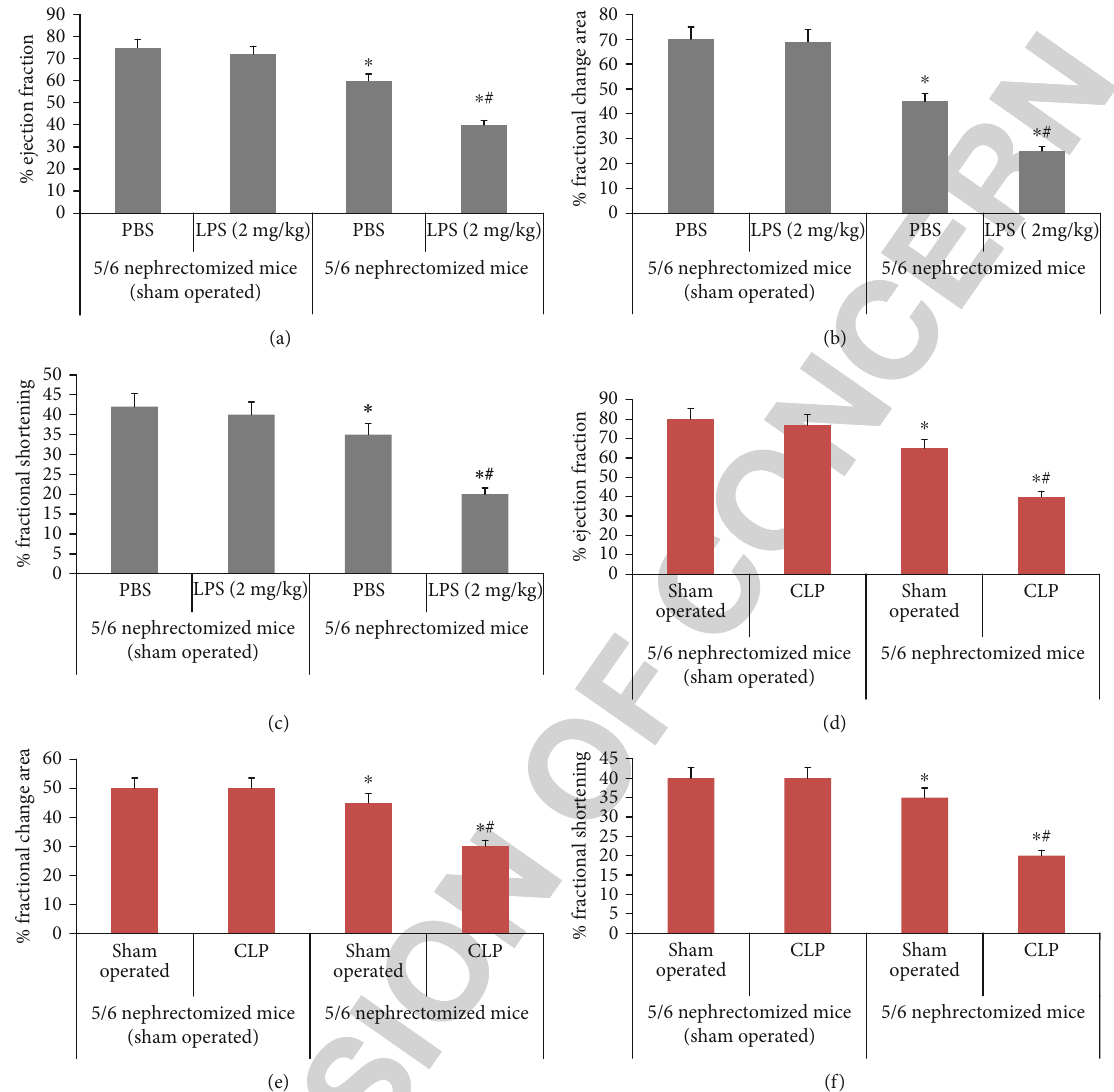
Figure 1: 5/6 nephrectomy-induced chronic kidney dysfunction causes augmentation of cardiac dysfunction mediated by LPS administration or CLP. (a – c) 5/6 nephrectomized sham or 5/6 nephrectomized mice were treated with either LPS (2 mg/kg) or vehicle, i.e., PBS intraperitoneally. The cardiac function was evaluated after 18 hours. Data representing percentages of (a) EF, (b) FCA, and (c) FS. The group evaluated were 5/6 nephrectomized sham and vehicle treated (PBS), 5/6 nephrectomized sham and PBS, 5/6 nephrectomized sham and LPS (2 mg/kg), and 5/6 nephrectomized and LPS (2 mg/kg). (d – f) 5/6 nephrectomized sham or 5/6 nephrectomized mice were submitted to CLP or sham surgery. The cardiac function was evaluated after 24 hours. Data representing percentages of (d) EF, (e) FCA, and (f) FS. The groups evaluated were 5/6 nephrectomized sham, 5/6 nephrectomized and sham operated, 5/6 nephrectomized sham and CLP, and 5/6 nephrectomized and CLP. The data are presented as mean ± SEM . ∗ P < 0 : 05 compared to 5/6 nephrectomized sham group with respective treatments; # P < 0 : 05 compared to respective vehicle-treated (PBS) or sham